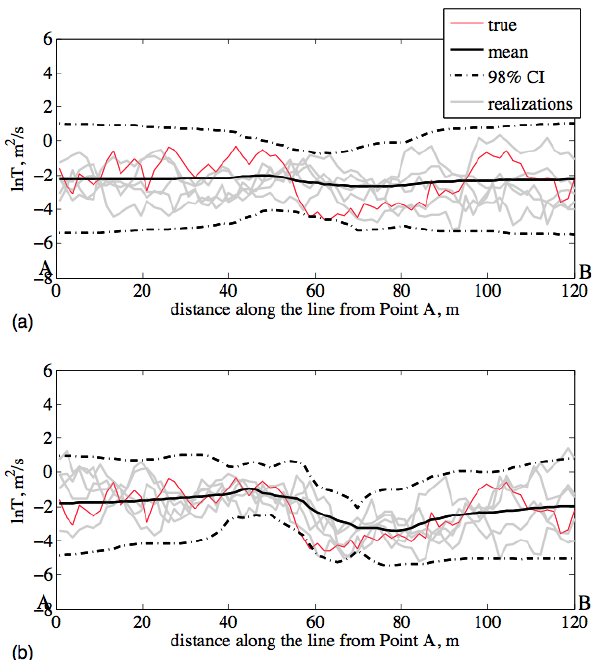
Fig. 6. Comparison among the reference field, the mean field and the 98% confidence interval of the generated fields, along the center line of the IFRC well field (Line A–B in Fig. 4), for the inversion based on (a) one test (injection at Well 2-18) and (b) three tests (injection at Wells 2-09, 2-24 and 3-24). The gray lines are the realizations of the fields.